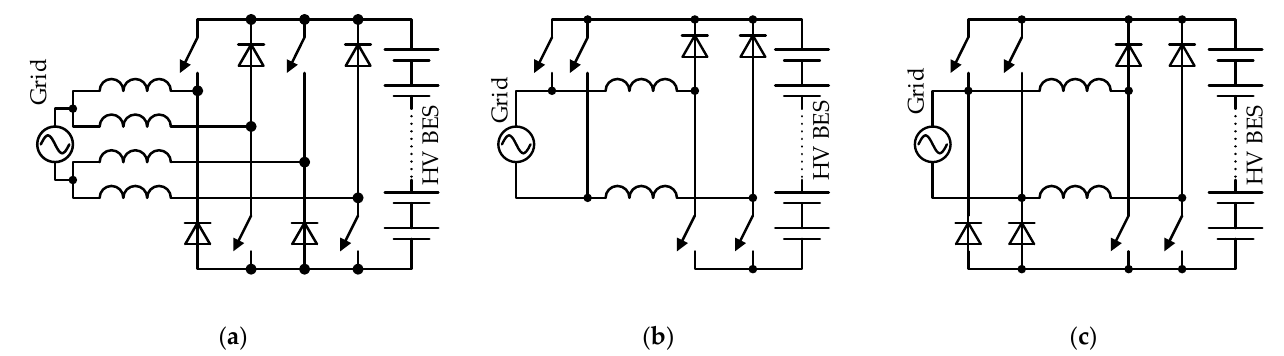
Figure 12. Dual-buck grid converters: ( a ) derived from full-bridge, ( b , c ) synthesized of two combined buck converters.